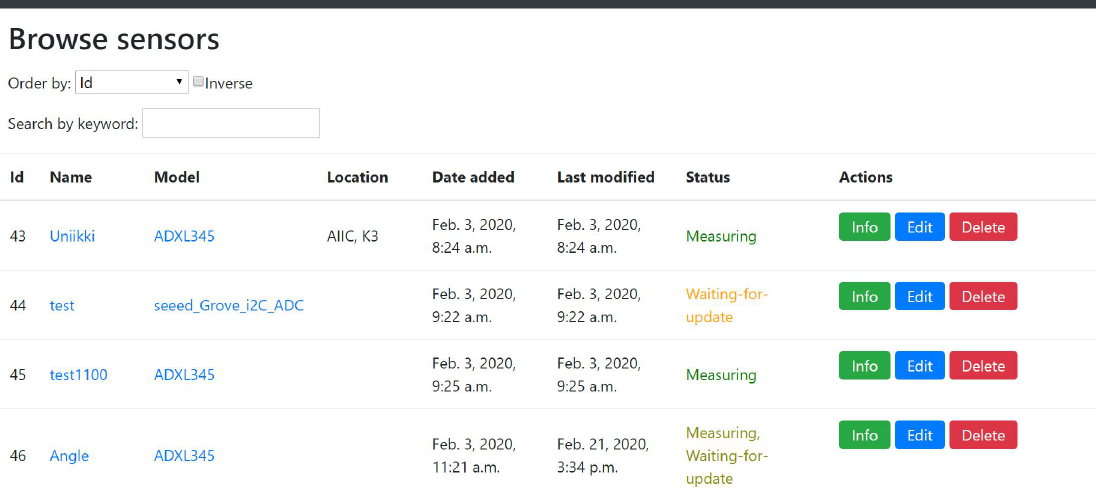
Figure 5. Browse sensor view, which shows all sensor nodes in